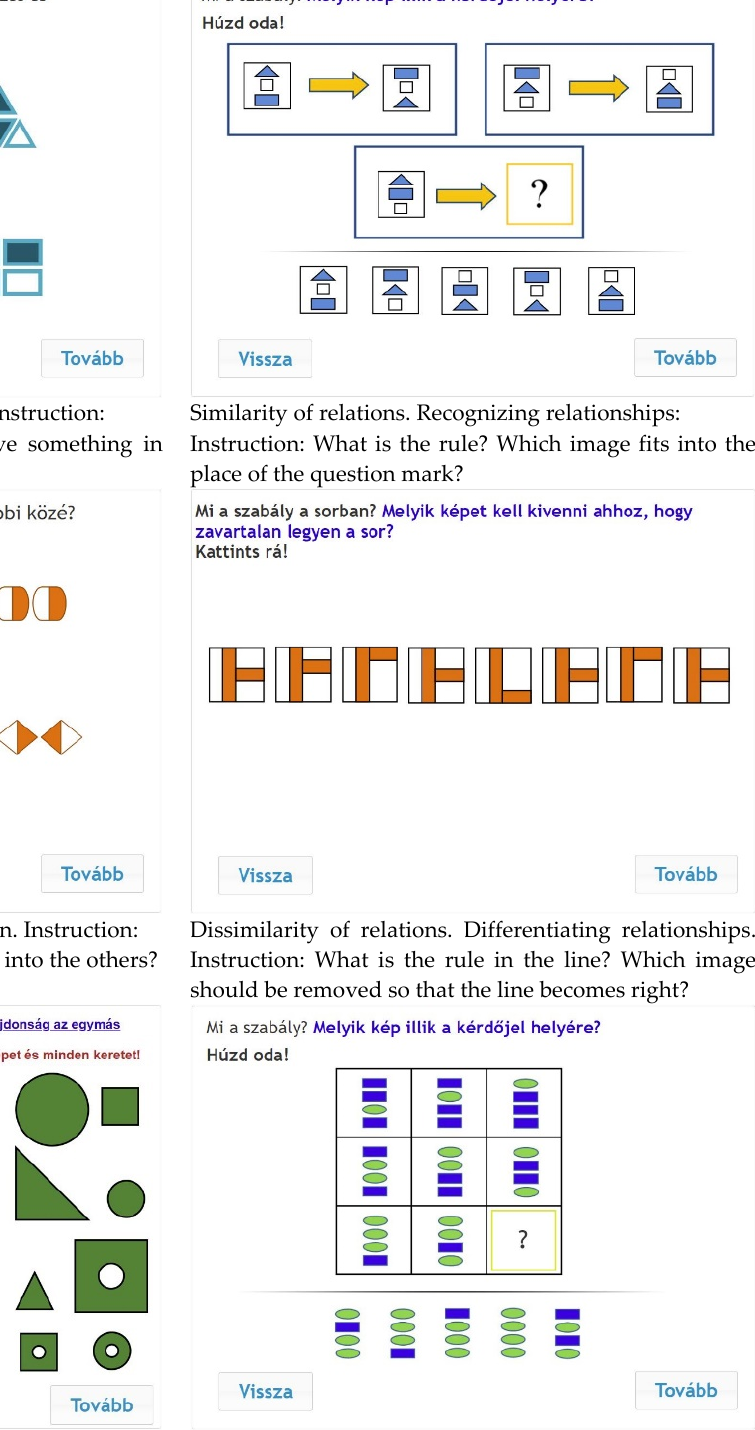
Figure 2. Sample items from the inductive reasoning test.